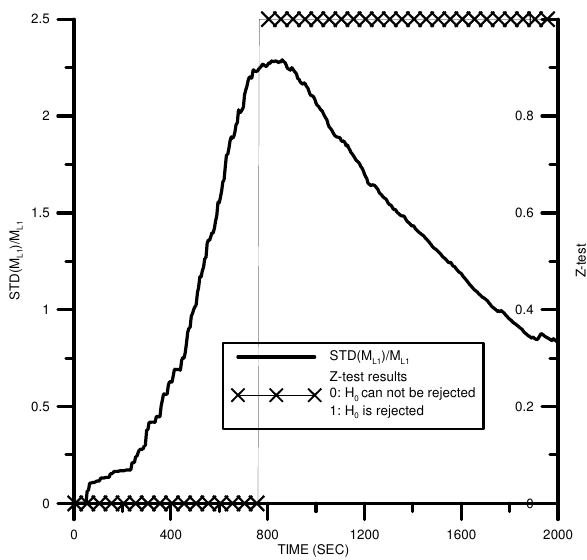
Fig. 5. Time evolution of the second moment of the distribution Figure 5. Time evolution of the second moment of the distribution for the product for the product kernel ( K(x,y)= Cxy ), calculated from the numerical solution of the KCE. kernel ( K(x,y)= Cxy ), calculated from the numerical solution of the KCE.